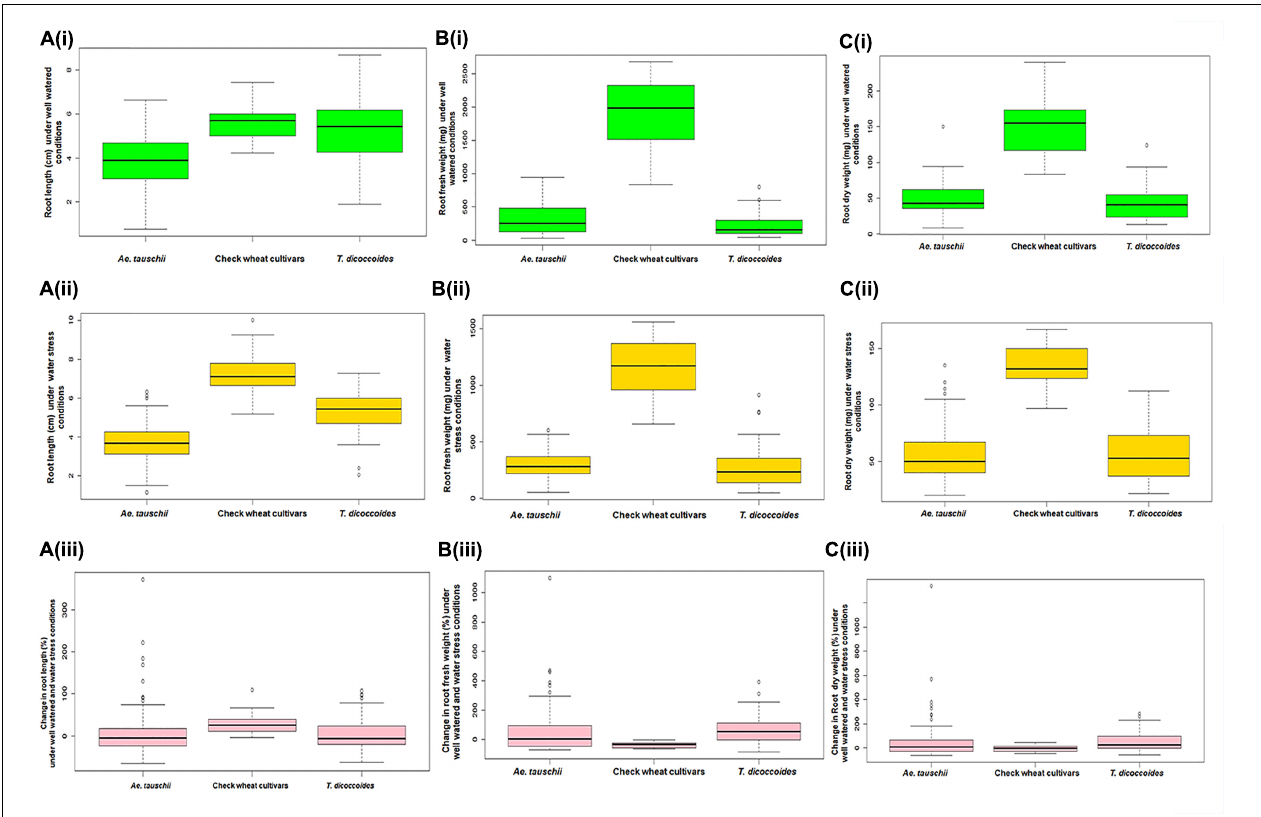
FIGURE 2 | Boxplot representation of root traits of accessions of Ae. tauschii , T. dicoccoides and check wheat cultivars under well watered and water stress conditions. (A) Root length under (Ai) well watered, (Aii) water stress conditions, and (Aiii) change in root length under well watered and water stress conditions. (B) Root fresh weight under (Bi) well watered, (Bii) water stress conditions, and (Biii ) change in root fresh weight under well watered and water stress conditions. (C) Root dry weight under (Ci) well watered, (Cii) water stress conditions, and (Ciii) change in root dry weight under well watered and water stress conditions.